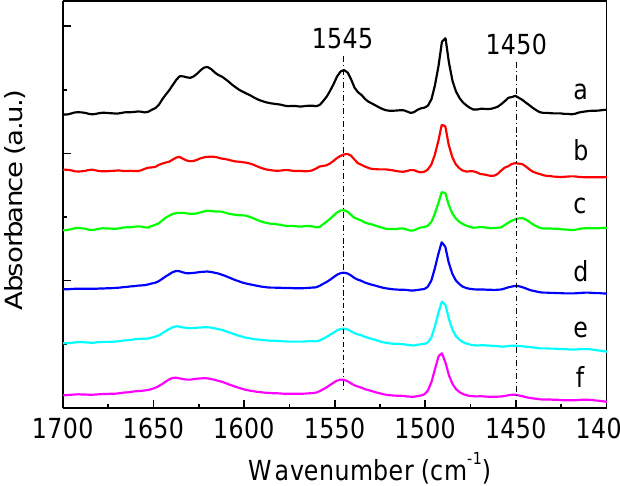
Figure 5. FT-IR spectra of pyridine adsorption on parent and P-modified HZSM-5 zeolites: ( a ) HZSM-5, ( b ) 0.5% P/HZSM-5, ( c ) 1% P/HZSM-5, ( d ) 2% P/HZSM-5, ( e ) 3% P/HZSM-5 and ( f ) 5% P/HZSM-5.